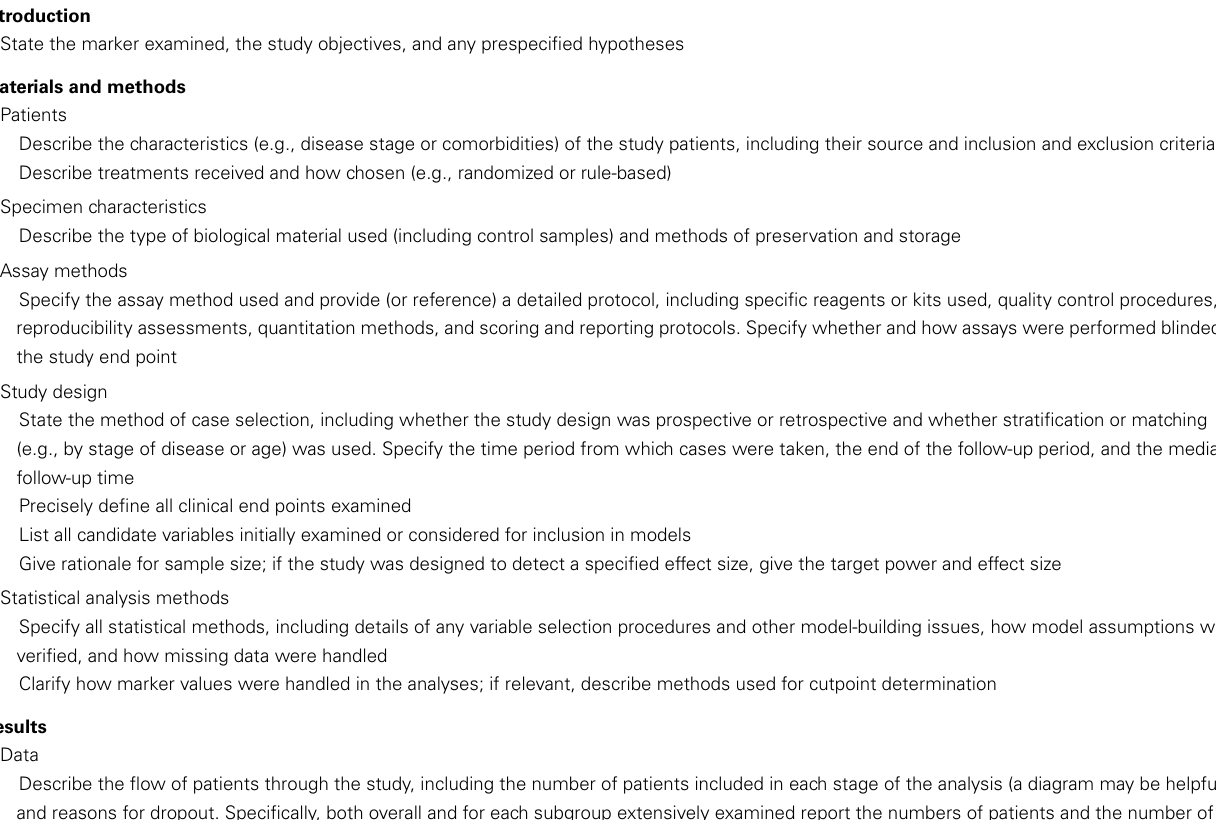
Table 2 | Reporting recommendations for tumor marker prognostic